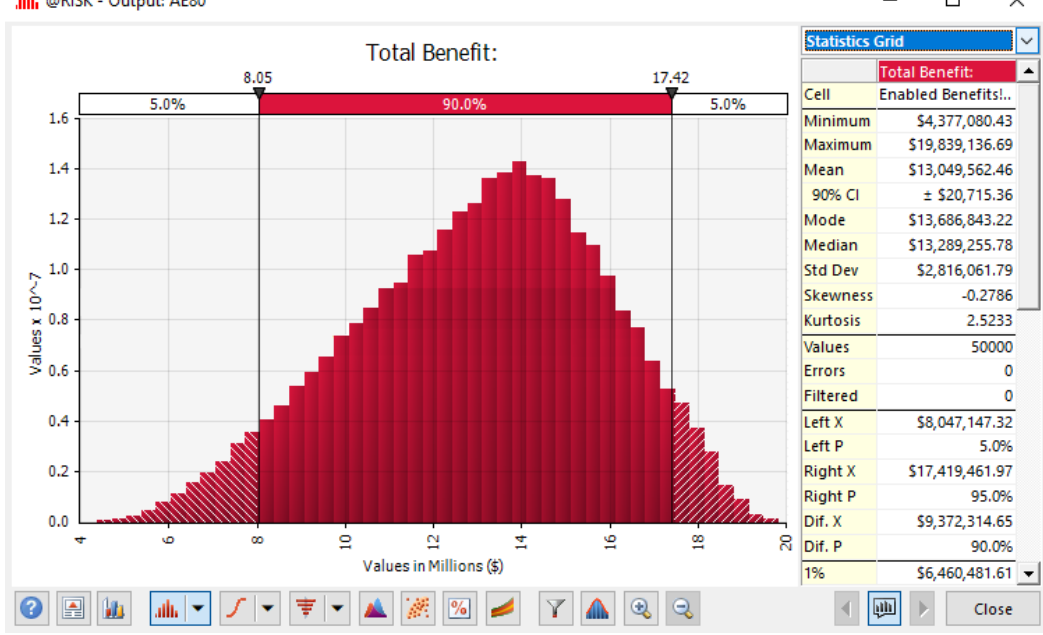
Figure 11. Indication of how benefit values can be used, as input to Monte Carlo simulations (histogram, red bars) to show relative frequency (y-axis) of total benefit value (AUD$ millions, x-axis) based on hypothetical annual operating costs and @Risk v7.6, 50,000 iterations. (Results are illustrative only and included to show potential outputs).